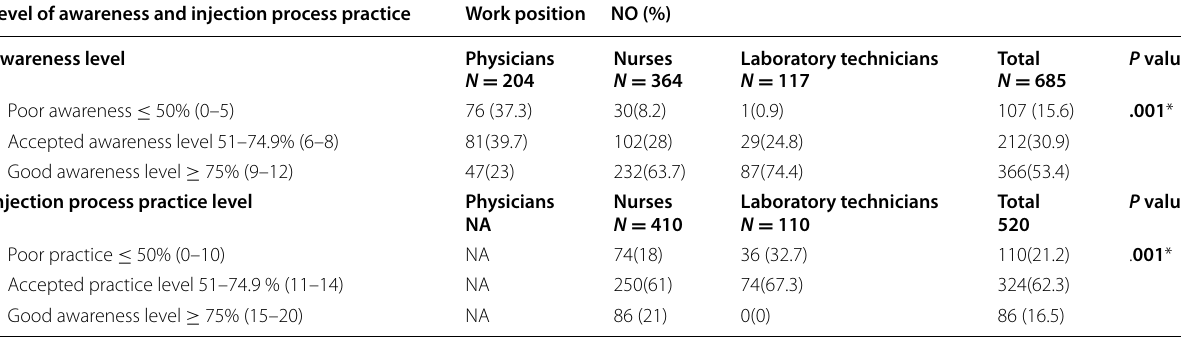
* P value 0.05 is considered significant ≤